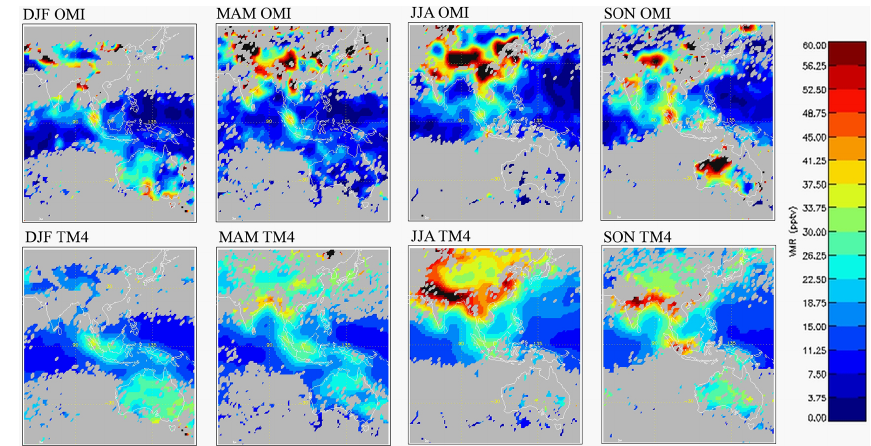
Figure 24. Asian sector at 280hPa: seasonal variability in OMI (top row) versus TM4 model (bottom row) average NO 2 VMR pseudoprofiles for the year 2006.